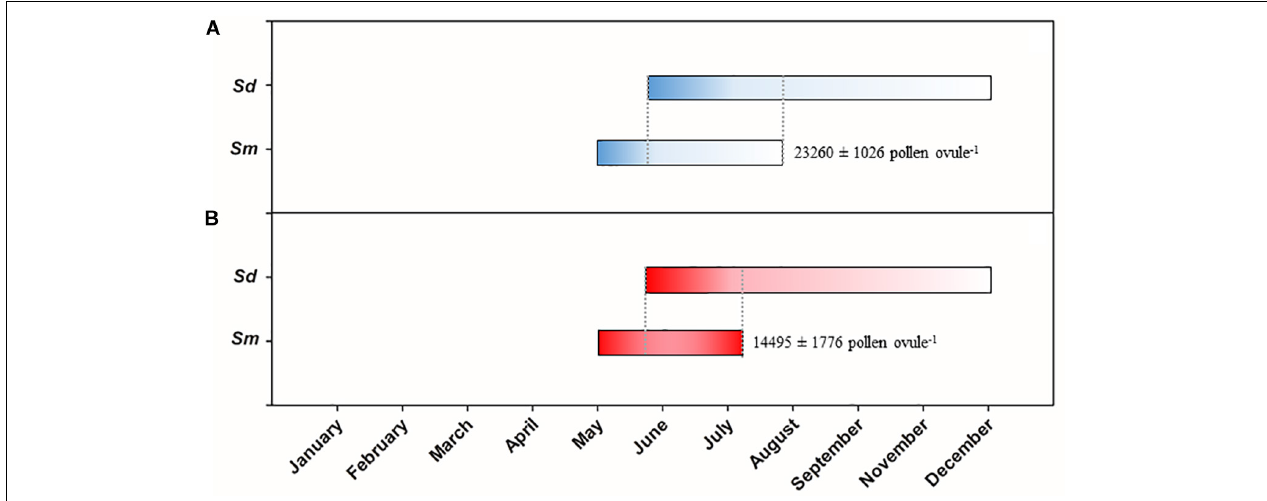
FIGURE 5 | Flowering periods of native Spartina maritima ( Sm ) and invasive S. densiflora ( Sd ) in (A) 2018 (a mild flowering period) and (B) 2017 (a warm flowering period). Darker color represents the predominance of pistils in the inflorescence and lighter color is the predominance of stamens. The pollen:ovule ratio of S. maritima is indicated nearby its flowering bars. The flowering period of S. densiflora was obtained from Valdes et al. (1987) and Castillo and Figueroa